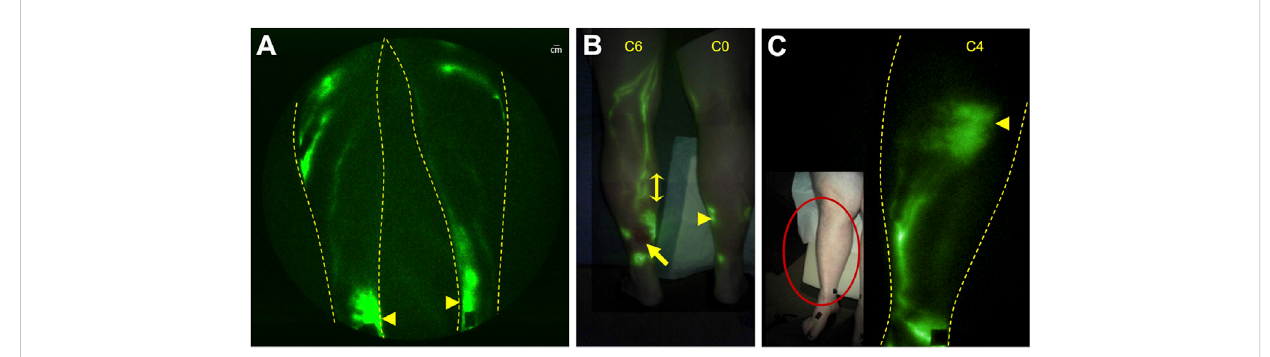
FIGURE 9 NIRF-LI in chronic venous disease. (A) Pooling (arrowsheads) was commonly observed in the medial ankles of subjects, including in a limb with no visiblevenousdisease. (B) Lymphaticre fl ux(double-headed arrow)wasobservedinthelymphaticsdraininganulcer(arrow)inthelegofonesubject(See Supplemental Video S2). (C) Dermal back fl ow (arrowhead), with reduced lymphatic pumping, was observed in a subject with C4 disease. Reproduced with permission from (Rasmussen et al., 2016; Rasmussen et al.,